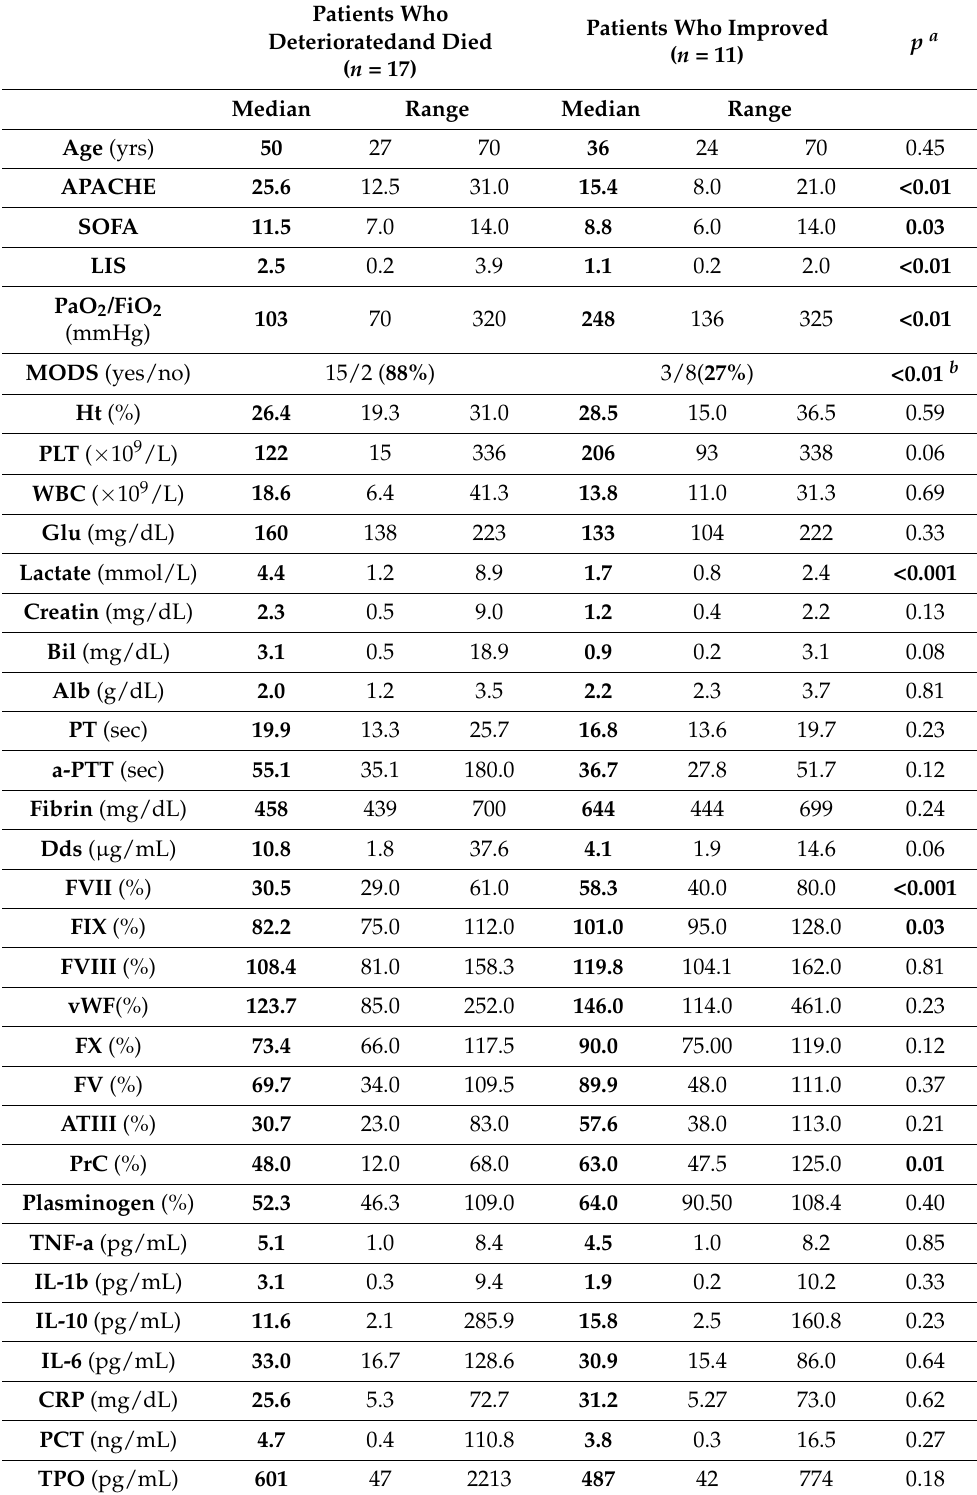
Table 7. Diagnosis of Septic Shock on ICU